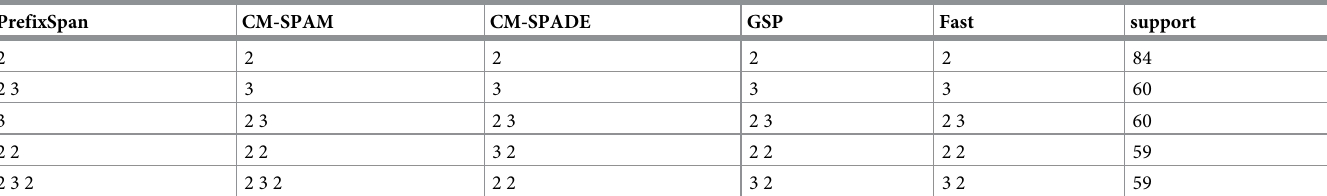
Table 7. Top five PrefixSpan-obtained patterns with the largest support: Scoring+1 dataset. PrefixSpan